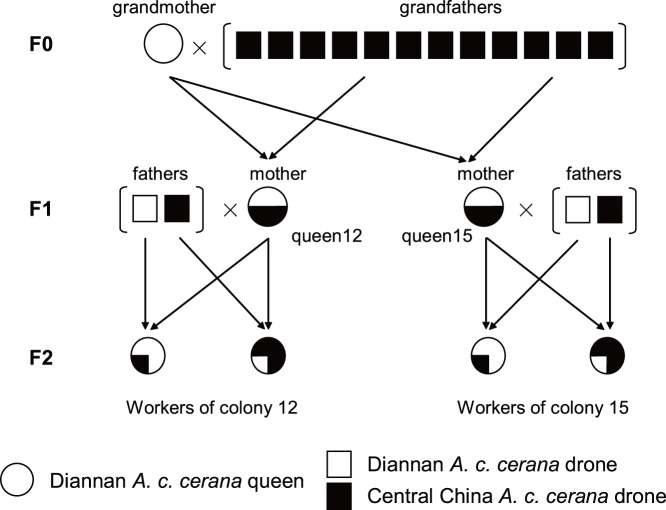
An intercross population performed to obtain workers for map construction.The grandmother was Diannan ACC queens (white, circle) and it was instrumentally inseminated with the sperm admixture from 12 drones (grandfathers) of Central China ACC drones (black, square). Two hybrid queens 12 and 15 (mothers, black/white, circle), were backcrossed to two males (the fathers), one belonging to Diannan ACC and the other one Central China ACC. The female progeny (workers) of these backcrosses were collected from two families (queens 12 and 15).